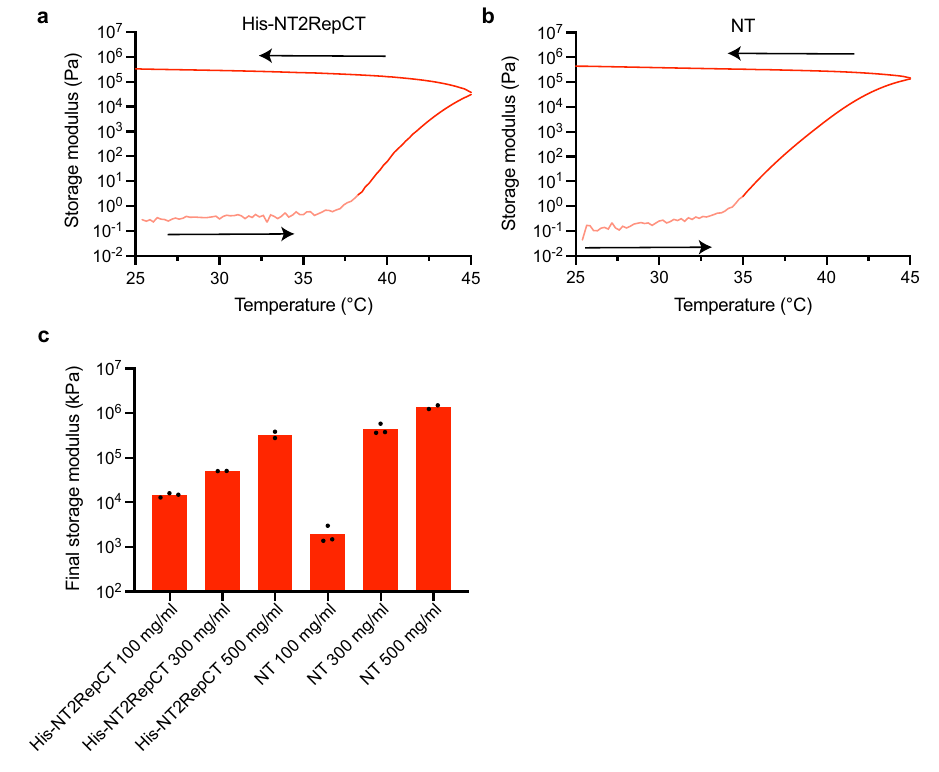
Fig. 2 | Rheological analyses of His-NT2RepCT and NT gelation. a Temperature ramp during oscillatory measurement of His-NT2RepCT (300mg/ml) and b NT (300mg/ml). Arrows indicate temperature course, lighter shaded portions of the storage modulus data depict testing below the manufacturers stated lower torque